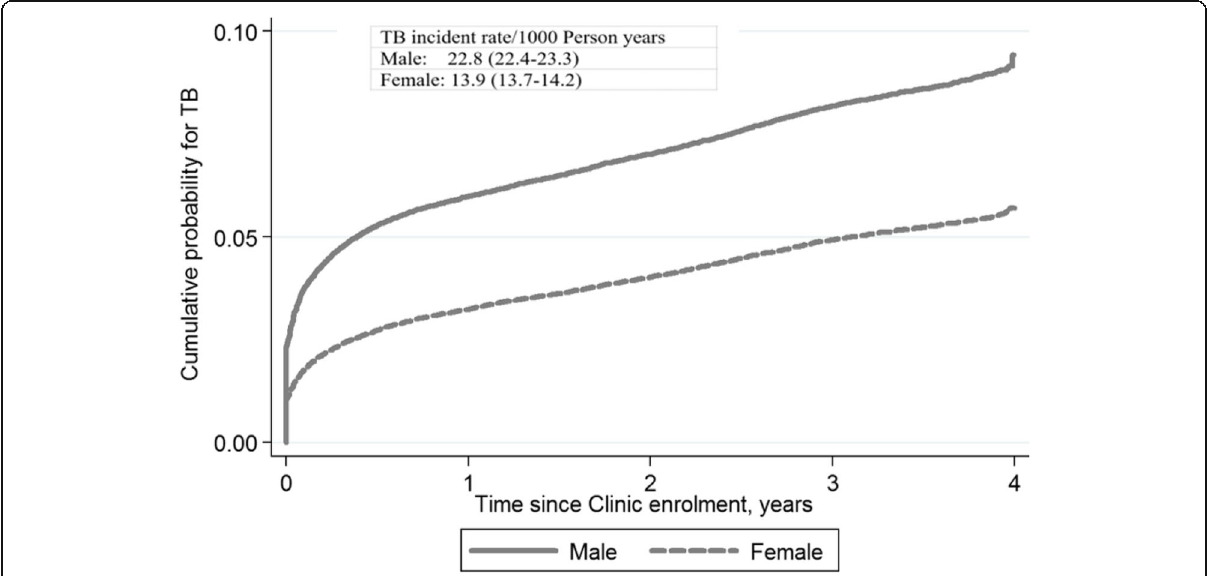
Fig. 3 Cumulative probability of TB incident after enrollment to HIV care and treatment by age and